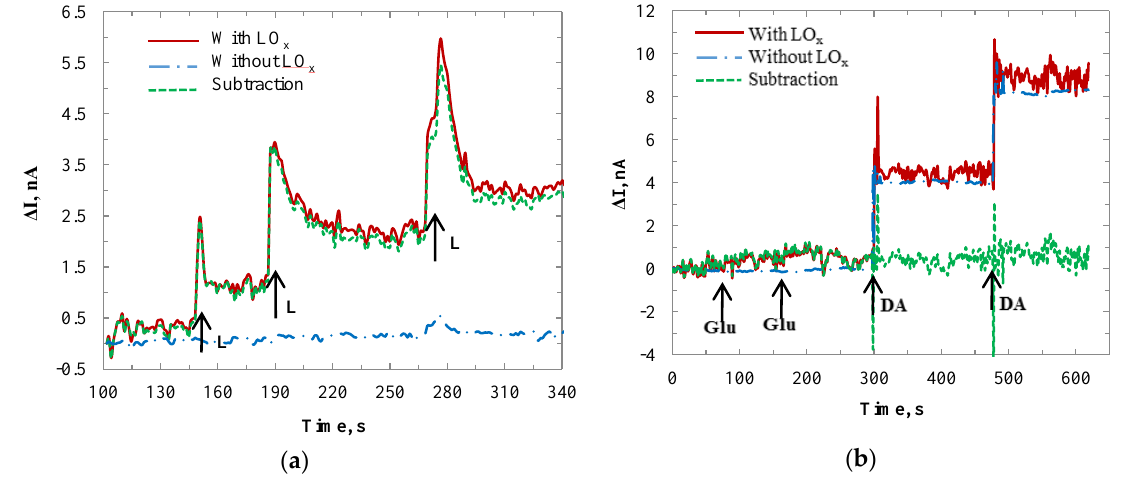
Figure 10. Time-current plot for the IrO x modified WE (with LO x ) and SE (without LO x ) in PBS with responses to ( a ) lactate and ( b ) glutamate and dopamine.